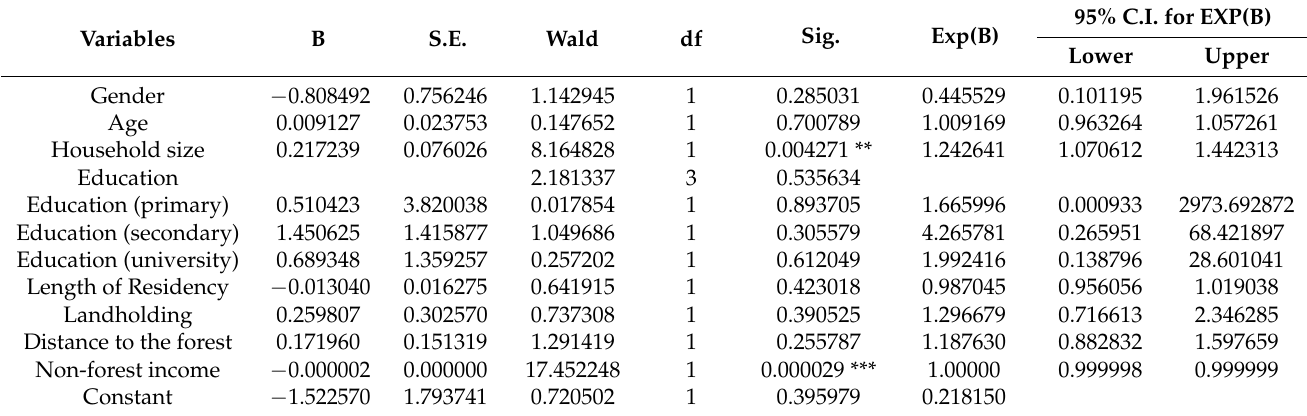
Table 5. Determinants of household forest dependency (Logistic regression